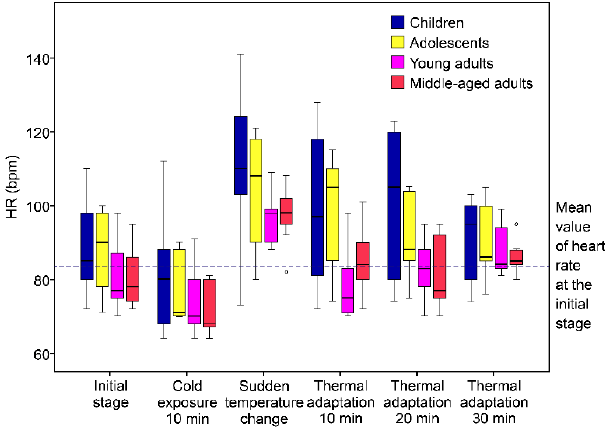
Figure 10. Law of HR deviation for different age-groups in different temporal phases under the 24 °C condition.